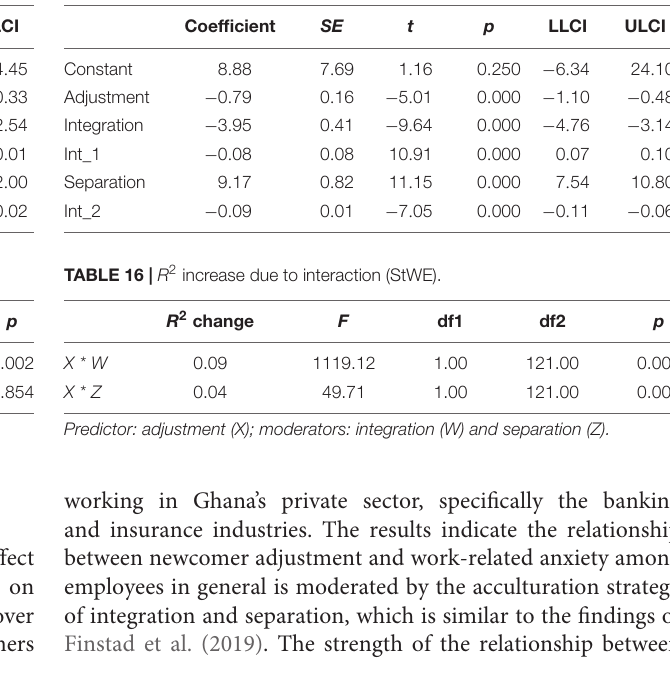
TABLE 13 | Moderation model with turnover intentions as dependent variable (StWE).